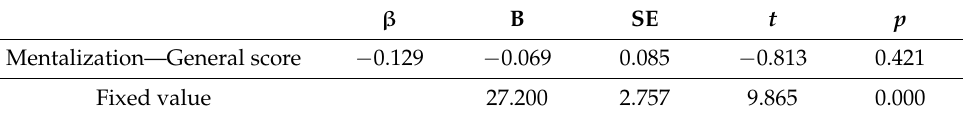
Table 8. Predictors of fighting spirit.